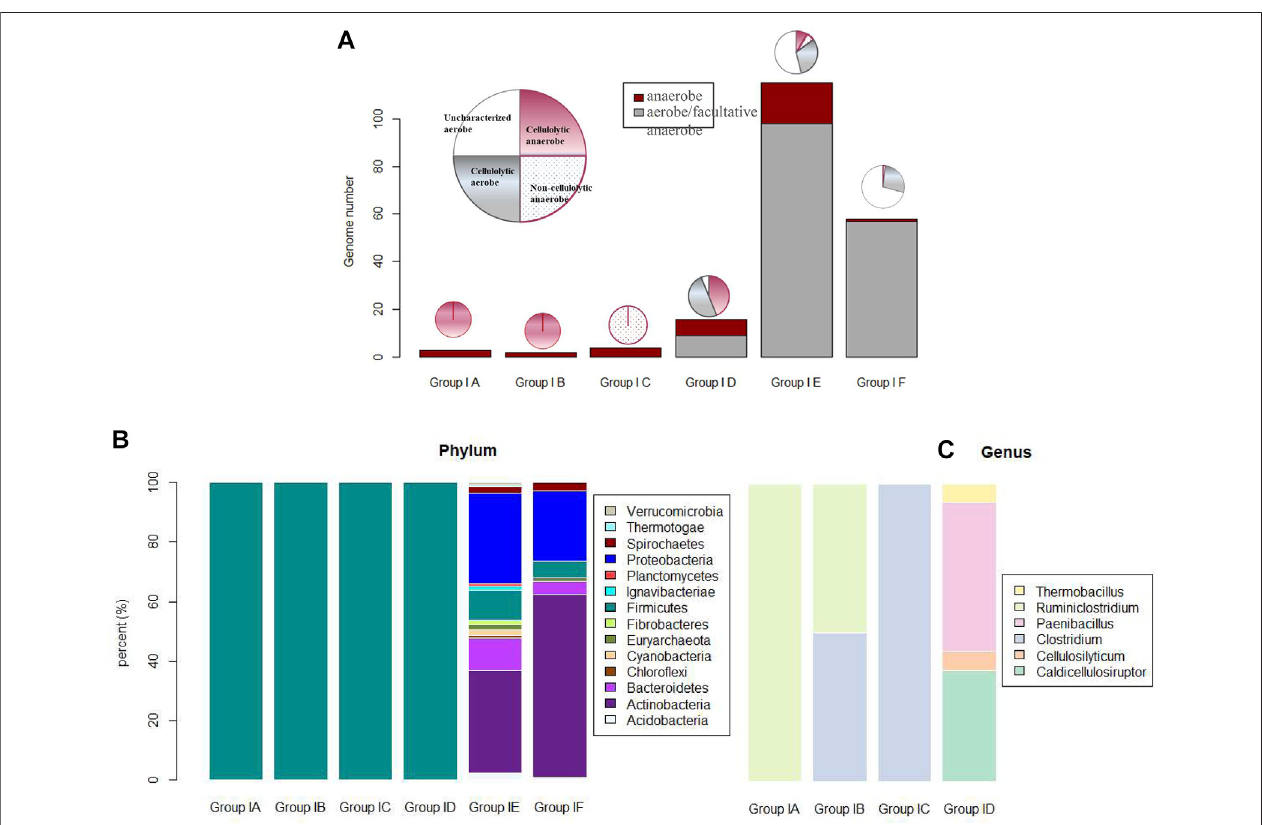
FIGURE 4 | (A) Phenotype features (i.e., anaerobic, aerobic, cellulolytic/noncellulolytic/uncharacterized) of microbe strains categorized in six genotype groups (I-a to I-f); (B) phylum af fi liation of microbe strains in the six genotype groups; and (C) genus af fi liation of microbe strains in the fi rst 4 genotype groups of I-a to I-d. Due to challenges associated with color assignment for the 114 genera of microbe strains in group I-e and group I-f, genus af fi liation of microbe strains in these two genotype groups are not visualized in this fi